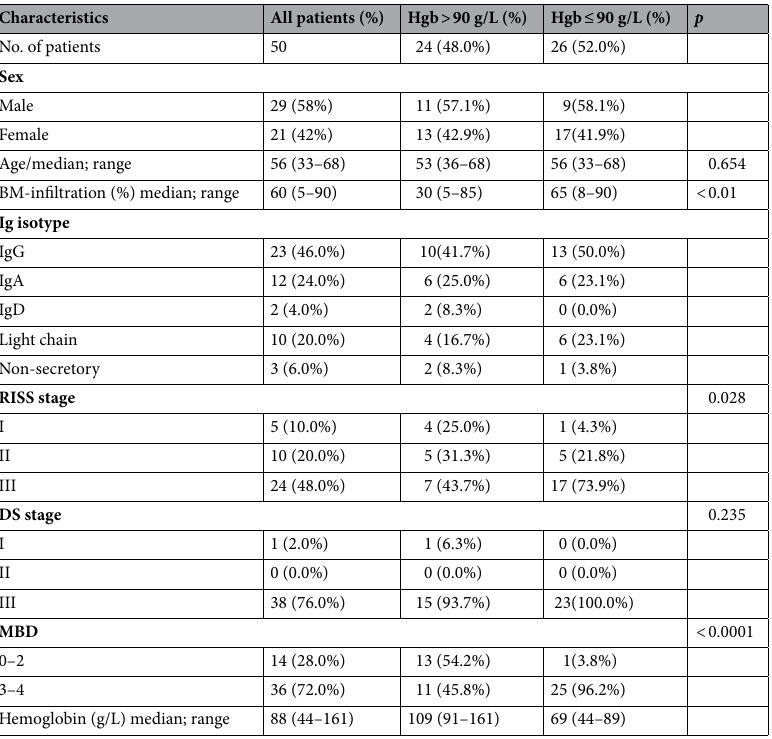
Table 2. Baseline characteristics of 50 NDMM patients. RISS Revised international staging system, DS Durie Salmon, MBD myeloma bone